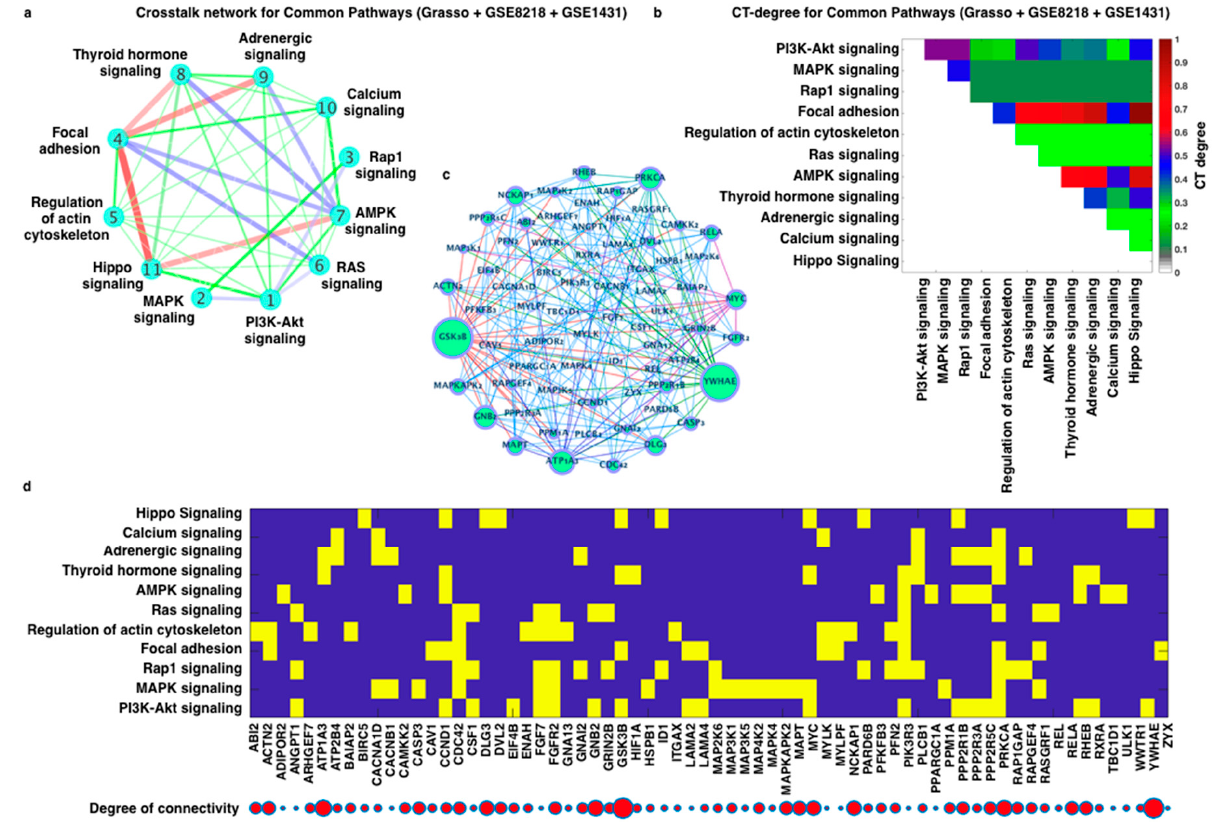
Figure 5. Crosstalk between the common enriched pathways: ( a ) genes belonging (in yellow color) to the crosstalk (pathway–pathway interaction) network and total connectivities for each gene (bigger circle means higher connectivities), ( b ) heatmap to represent the corresponding crosstalk degree between the pathways, ( c ) pathway–pathway interaction network for common enriched pathways among all the three datasets and the pathway components (gene–gene associations), and ( d ) genes shared by the 11 pathways present in pathway–pathway interaction network and their degree of association within the crosstalk network for the corresponding genes.